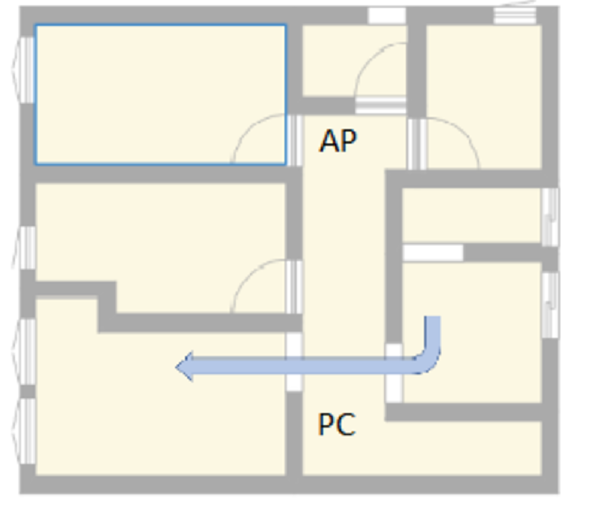
Figure 6. Scenario